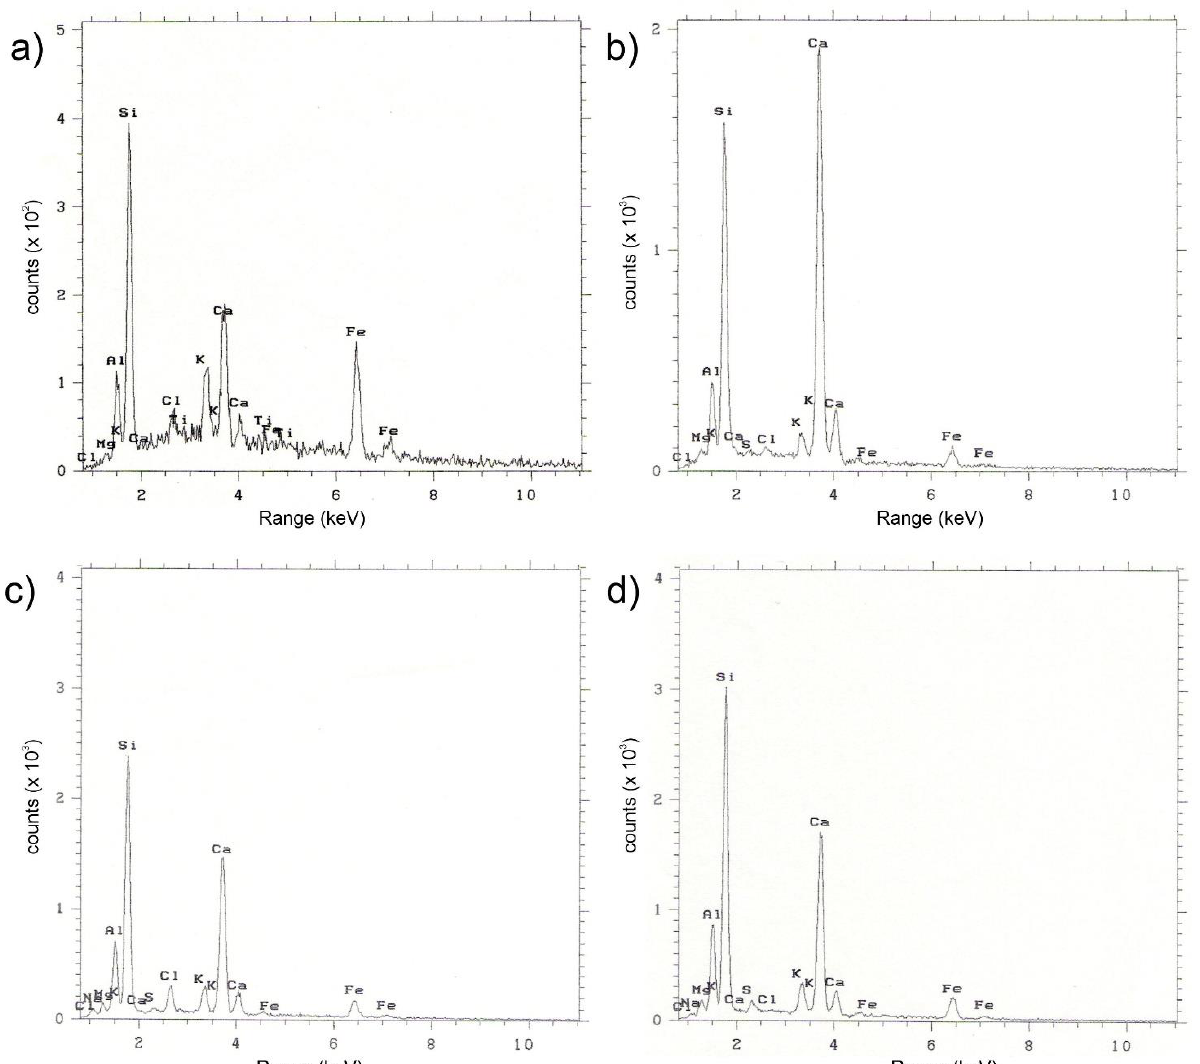
Figure 9. SEM analysis results. ( a , b ) C2-M and T2-V samples, respectively, with evident traces of chlorine; © C1-M and ( d ) C2-V with evident traces of sulfur.